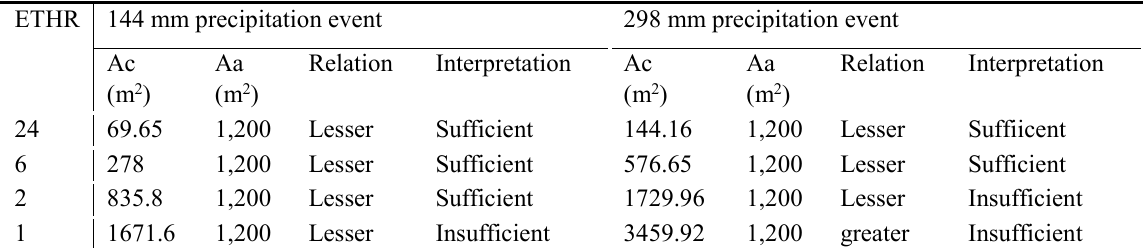
Comparison between river flow (Ac) against river channel (Aa) cross sectional area. ETHR